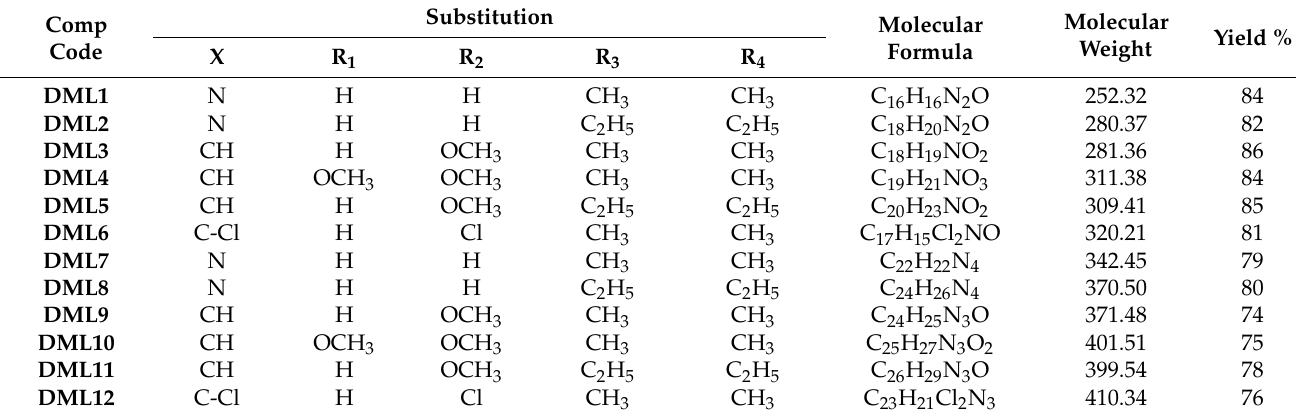
Table 1. Molecular structures, properties and reaction yields of compounds DML1 – DML12 .